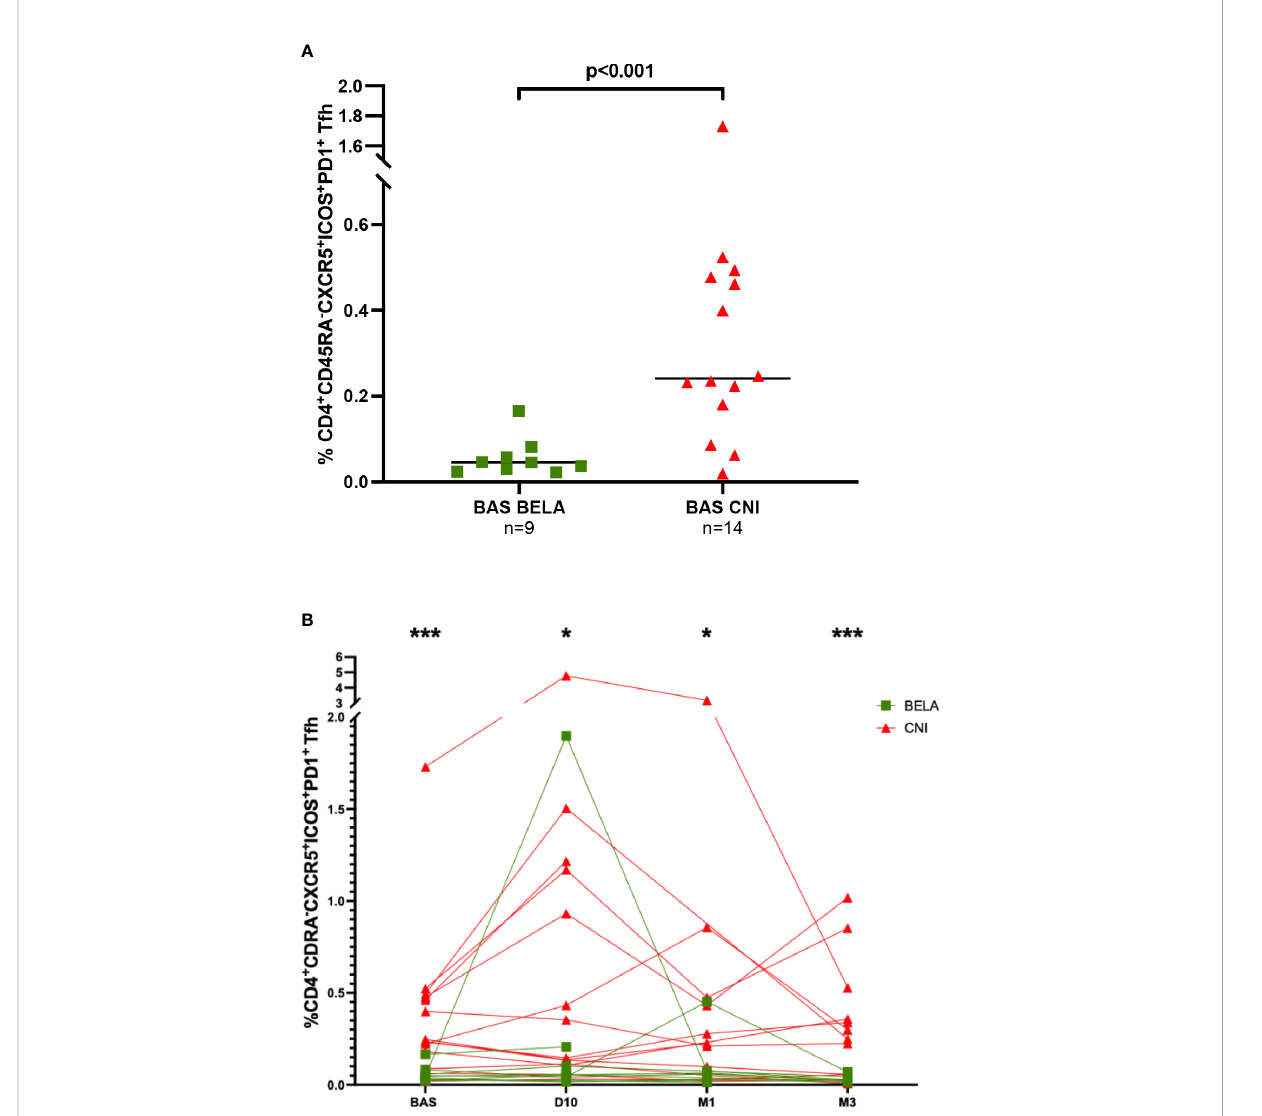
FIGURE 2 Comparison of the percentage of CD4 + CD45RA - CXCR5 - ICOS + PD1 + activated Tfh between the two study groups. Figure 2A. Baseline percentages of CD4 + CD45RA - CXCR5 - ICOS + PD1 + activated Tfh in the two study groups. Figure 2B. Kinetics of CD4 + CD45RA - CXCR5 - ICOS + PD1 + activated Tfh after in fl uenza immunization in the two study groups. The proportion of CD4 + CD45RA - CXCR5 - ICOS + PD1 + Tfh cells is expressed as a percentage in total lymphocytes in both fi gure 2A and 2B. Comparison of proportions between the two groups at each time point were analyzed using a Mann-Whitney Test. * p<0.05, ** p<0.01, ***p<0.001